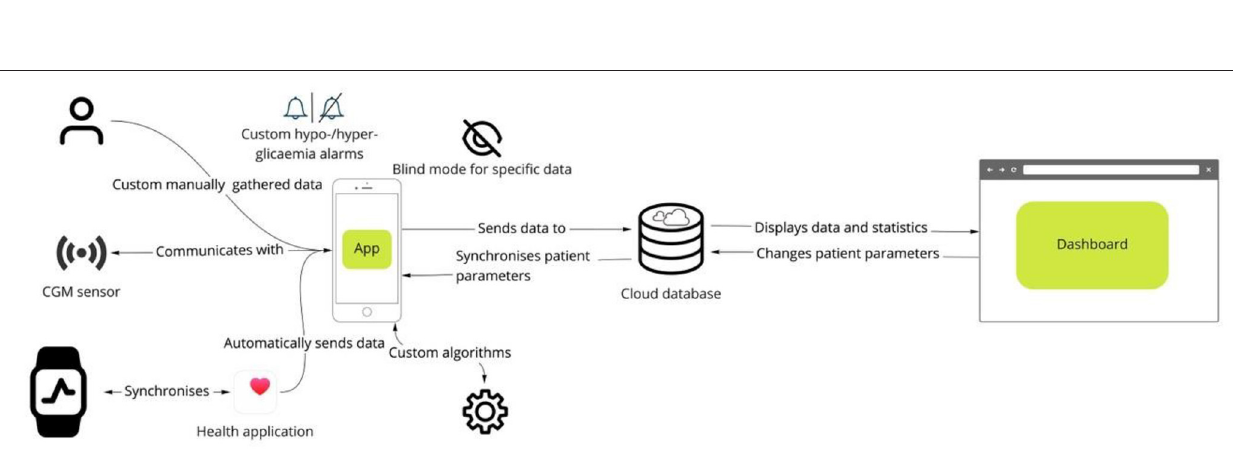
FIGURE 4 | Mobile application using digital receipts to optimize diet. The app screenshots provide insights into the functionalities of the app: daily overall nutritional value of purchased food (e.g., using the Nutri-Score) (left); food categories for individualized goal setting (center); food recommendations based on individual food purchase history and goal setting. The app currently exists only in German.